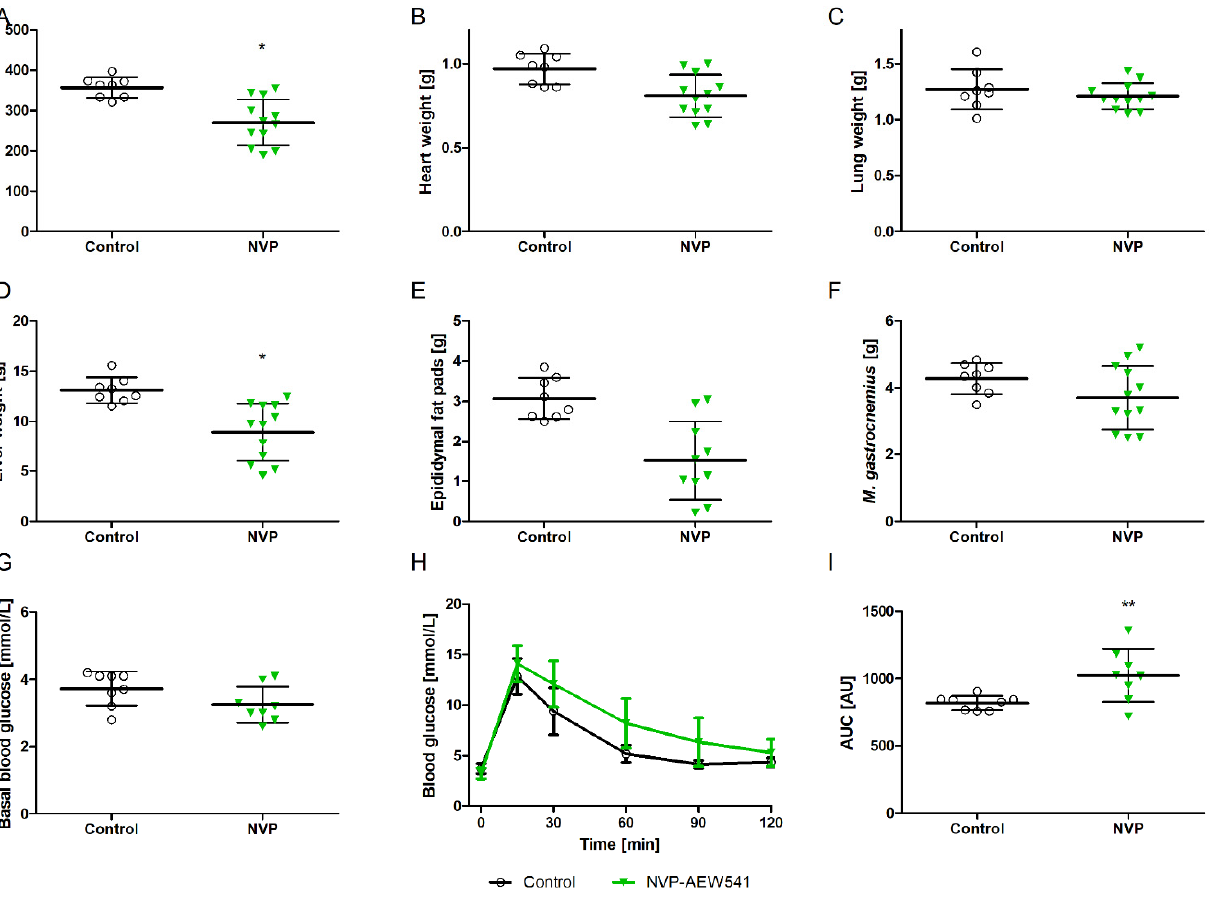
Figure 2. Effects of two weeks of NVP-AEW541 treatment (80 mg/kg) on the body and organ weights and the glucose tolerance of adult rats. Body weight ( A ), organ weights ( B – F ), fasting blood glucose ( G ), time course of glucose removal ( H ), and glucose tolerance ( I ) as determined by area under the curve (AUC). Data are presented as mean ± SD, n = 8–12 per group. Significant differences * p < 0.05; ** p < 0.01vs. vehicle.